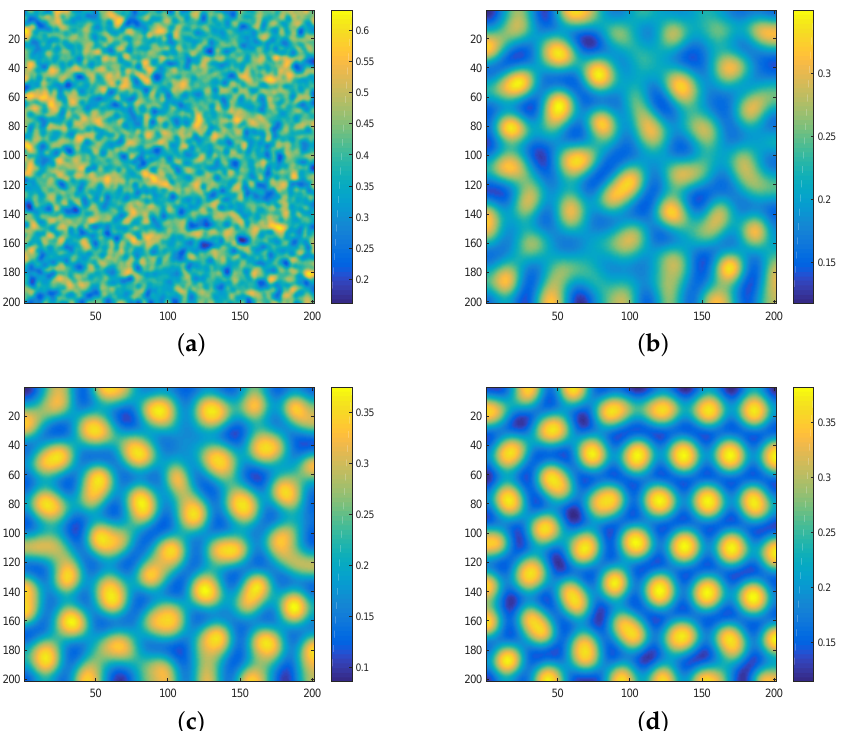
Figure 5. The patterns of prey evolution. Parameters: a = 0.14, b = 0.02, c = 0.7, s = 0.23, d 1 = 0.04, d 2 = 0.24. Times: ( a ) t = 0, ( b ) t = 150, ( c ) t = 300, and ( d ) t =